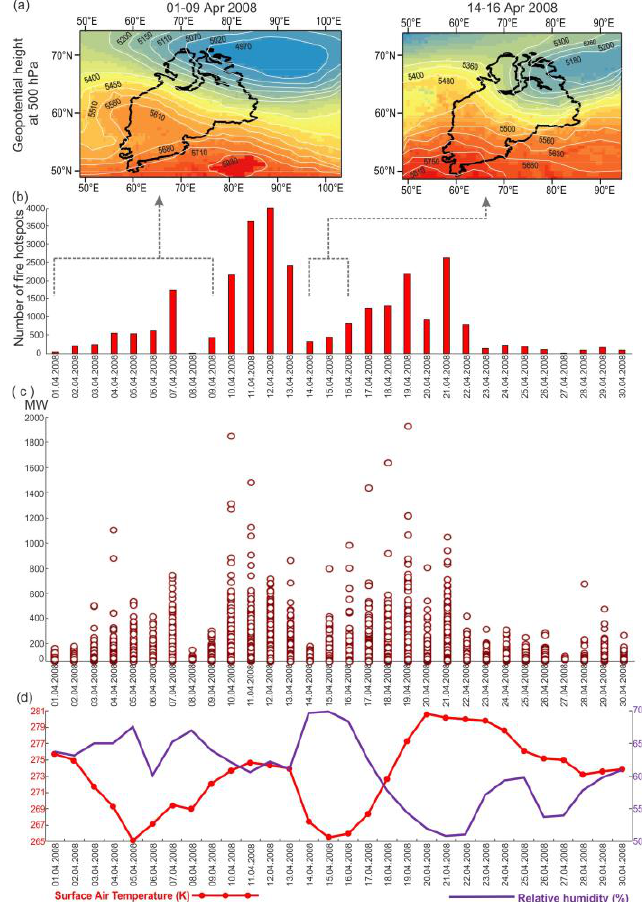
Figure 5. Changes in meteorological conditions and fire activity in the Ural Federal District in April 2008: maps of geopotential height changes ( a ); distribution of the daily number of wildfire hotspots ( b ); distribution of daily FRP values ( c ); changes in the surface air temperature and relative humidity ( d ).